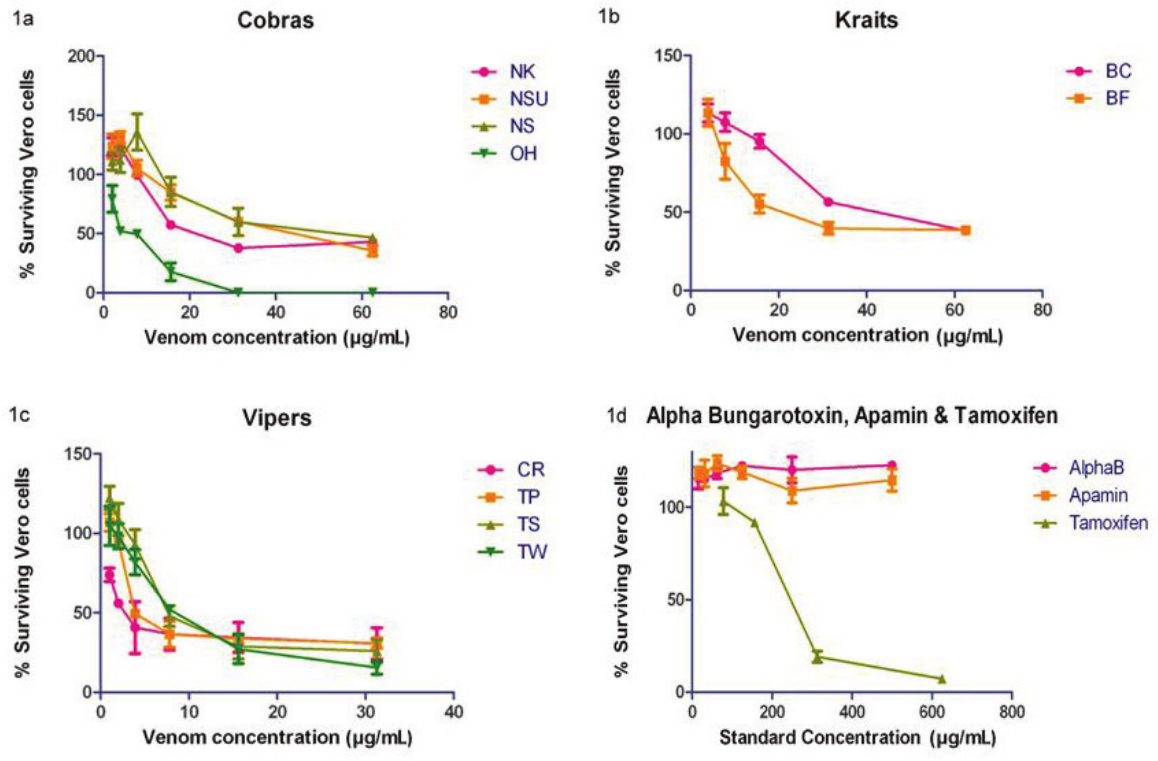
Figure 1. Cytotoxicity curves of snake venoms and standards in Vero cells. For each venom sample (n = 3); experiments were repeated three times and the results are displayed as mean values. Points are the means and bars are the SD